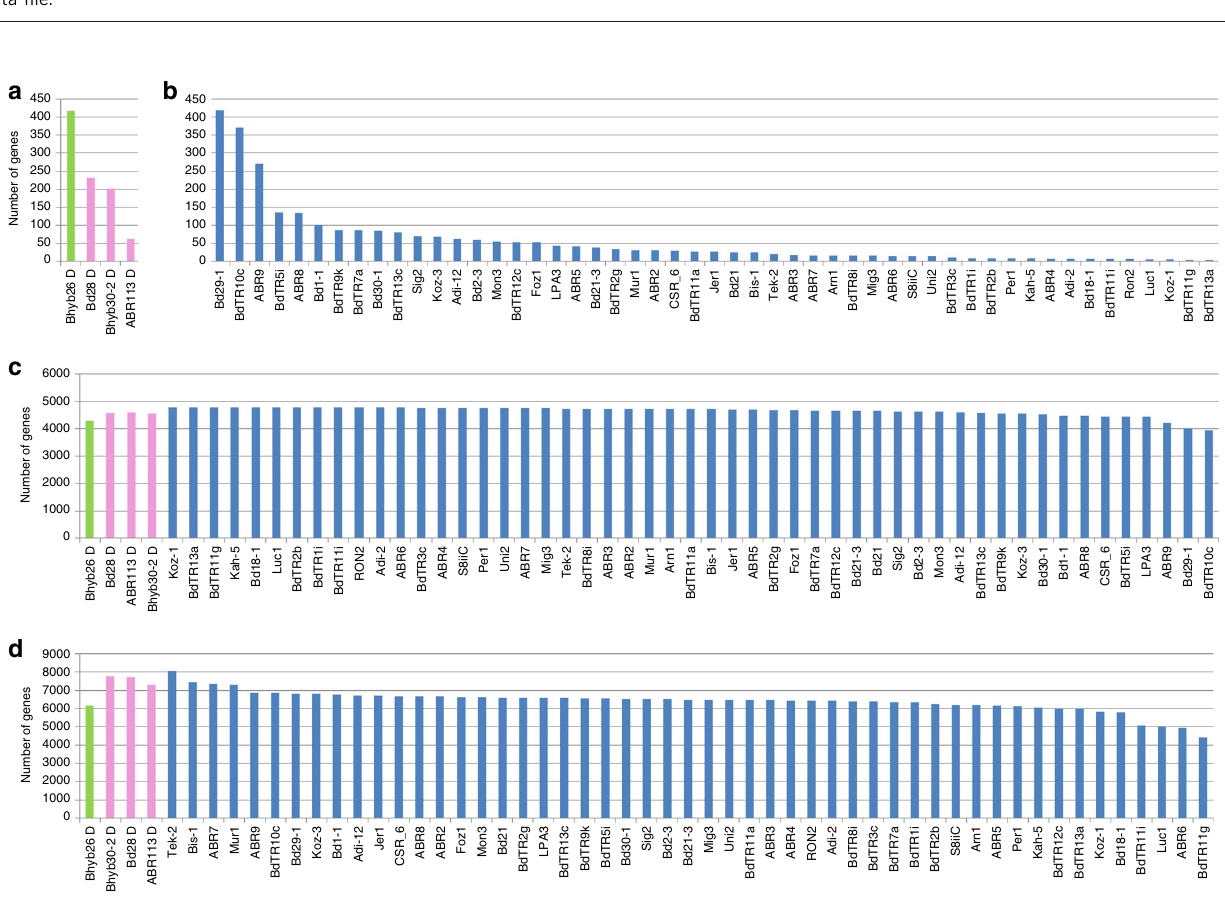
Fig. 6 K-mer analysis. a Three-dimensional kernel PCA (cosine kernel) plot showing the seven distinct classes of k-mers identi fi ed by the algorithm. Note the clear separation between classes. b – f Abundance of individual k-mers in each genome/subgenome are plotted for each k-mer class designated by color. The species, subgenome, and plastotype are indicated below the x axis. B.s. B. stacei . The classes correspond to expected histories of k-mer (repeat) abundance as follows: b repeats that expanded after the B. hybridum D-plastotype lines formed, but that did not expand in the S-plastotype lines (class 1); c repeats that proliferated in B. stacei , but not B. distachyon before the formation of all B. hybridum lines examined (class 2); d repeats that proliferated in B. stacei after the formation of the D-plastotype B. hybridum lines, but before the divergence of the S-plastotype B. hybridum lines (class 4); e repeats that proliferated in B. distachyon , but not in B. stacei before the formation of all B. hybridum lines examined (class 5); f repeats that show differential abundance in B. distachyon and B. hybridum lines, suggesting B. distachyon founder effects (class 6). However, the lines with the highest abundance (Bd21, ABR113, Bd28) are the lines with very complete assemblies, so technical bias cannot be ruled out. b – f Dots represent relative abundance of individual k-mers. Boxplots show the median and 25 – 75% range. Error bars are + / − 1 sd. Plots for classes 3 and 7 are in Supplementary Fig. 9. Source data are provided as a Source Data fi le.